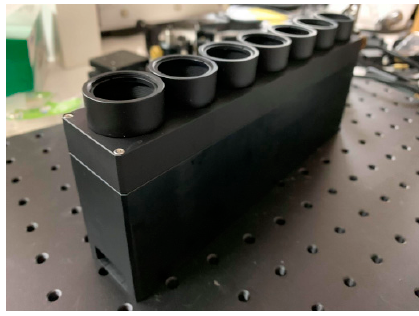
Figure 6. Photo of the demonstrated module. Energies 2020 , 13 , x FOR PEER REVIEW